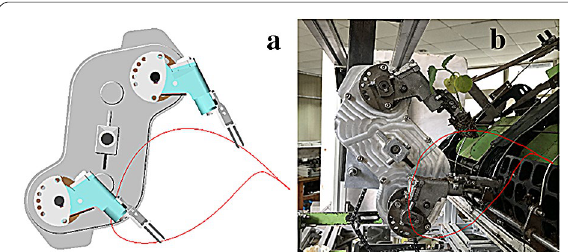
Figure 18 Motion trajectory: a virtual and b physical